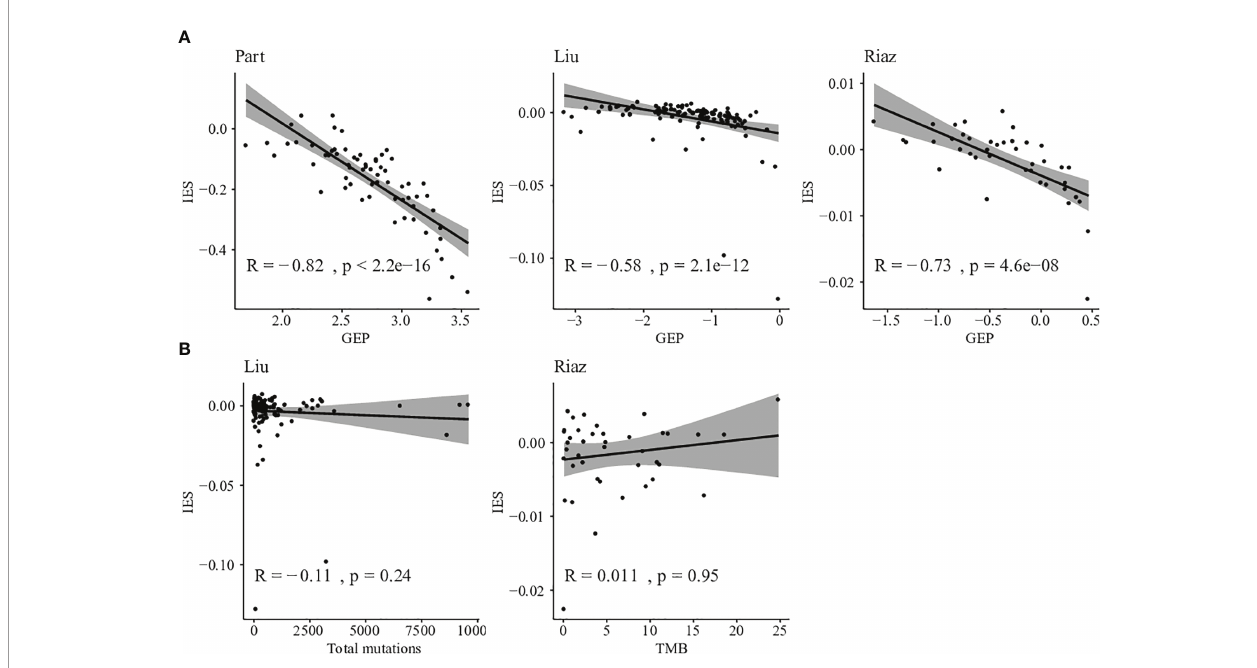
FIGURE 5 | Comparison between IES and other biomarkers. (A) Correlation between T cell – in fl amed GEP score and IES score in Prat, Liu, and Riaz cohorts. (B) Correlation between somatic mutation counts or TMB and IES score in Liu and Riaz